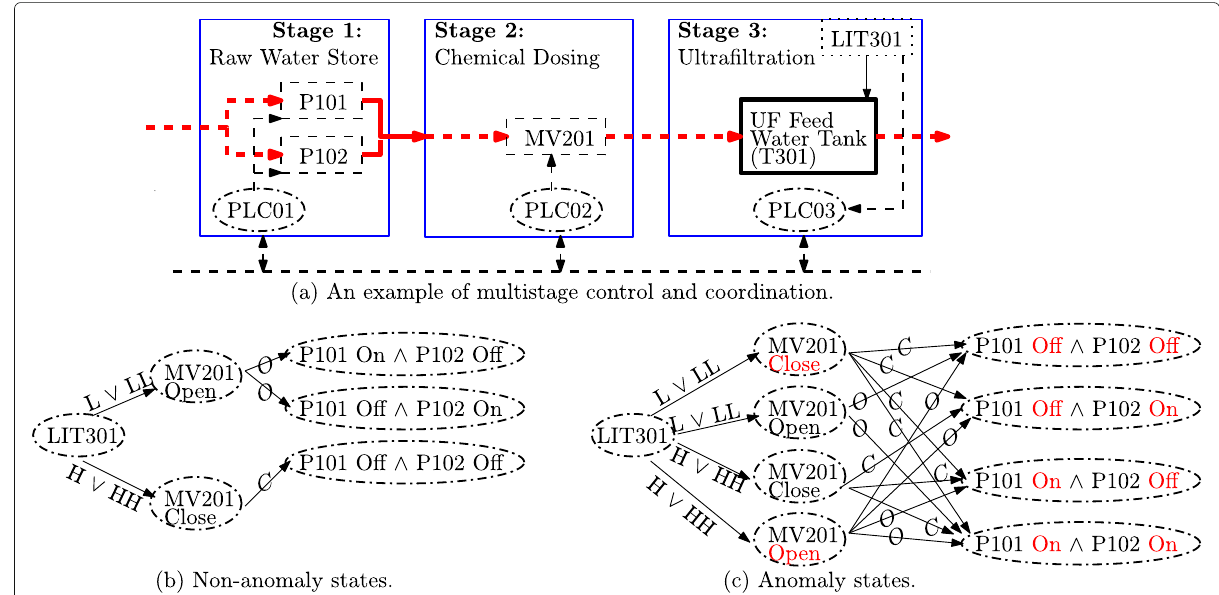
Fig. 6 Process graphs for Invariant #3. a Subsystems involved across three stages of SWaT; b a process graph for normal cases; c a process graph for anomalous cases